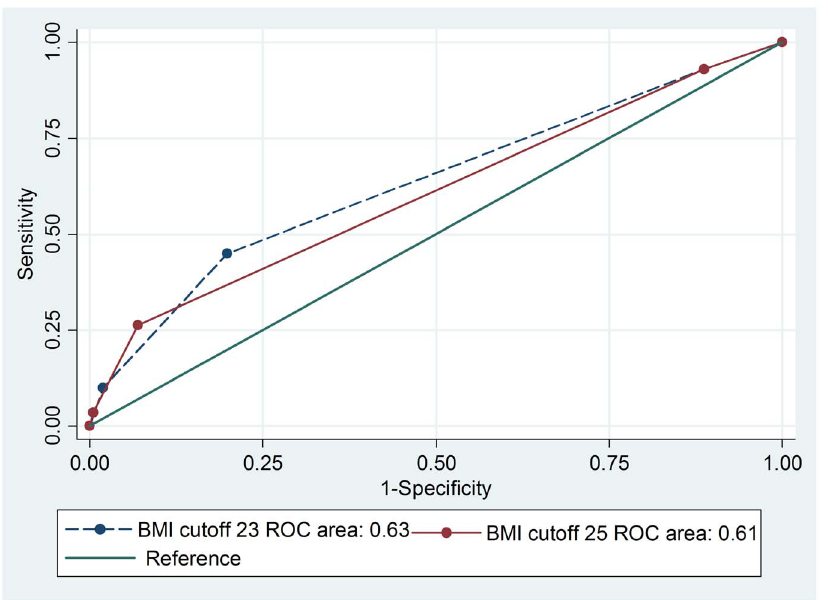
Figure 1. ROC curve comparing two BMI categories for predicting hypertension, diabetes mellitus and hypercholesterolemia in men.